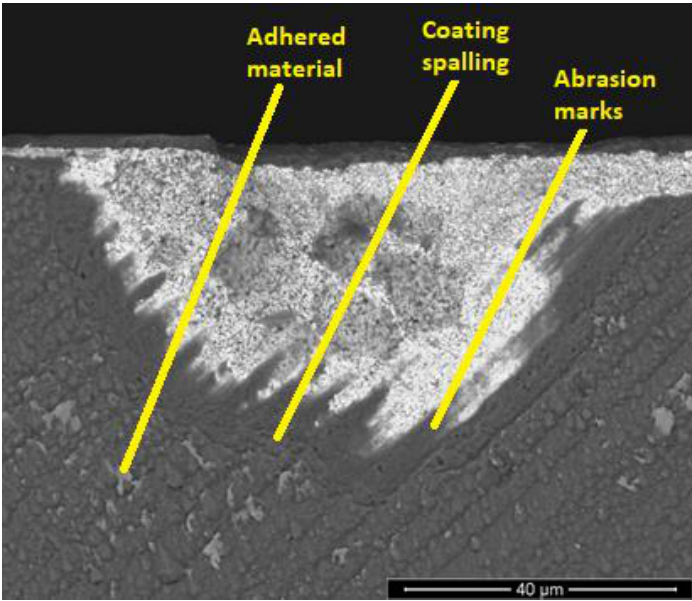
Figure 8. Wear mechanism analysis of the T1L2F125 rake face.